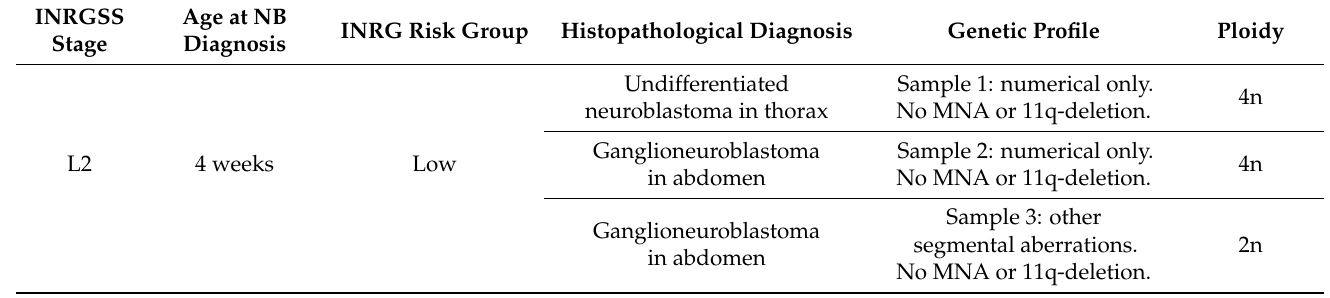
Table 1. Clinical